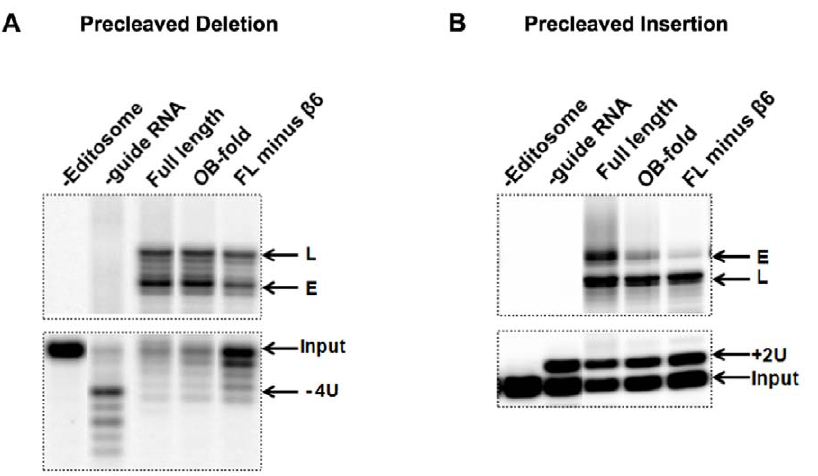
Figure 5. Editosome complexes co-purified with FL minus b 6 and OB-fold constructs can catalyze in-vitro editing assays. The pooled eluates (2&3) from the calmodulin column were used for in- vitro precleaved deletion and insertion editing assays as indicated. The lanes labelled as (- Editosome) and (-guide RNA) represent negative controls lacking either the editosome or the gRNA. (A) Precleaved deletion assay; Input RNA with four Us removed ( 2 4U), RNA edited by the deletion of 4 Us (E), and ligated RNAs without any Us removed (L) are indicated. (B) Precleaved insertion assay; Input RNA with two added Us ( + 2U), edited RNA with the insertion of two Us (E), and the ligated RNAs without any Us inserted (L) are indicated.